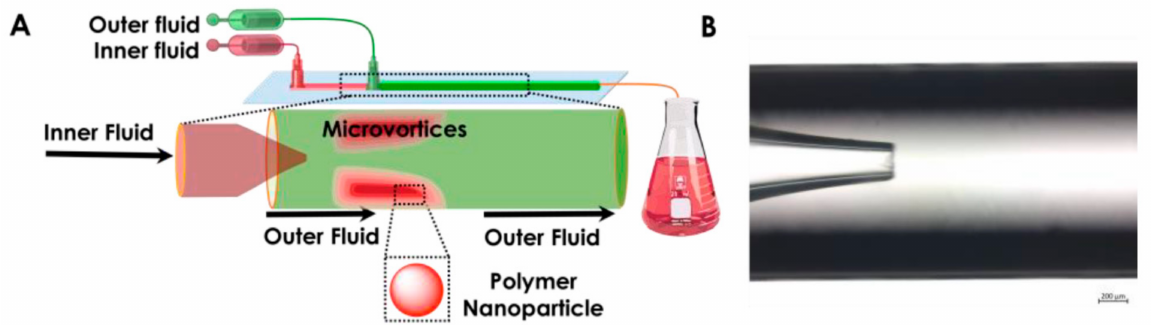
Figure 11. ( A ) Schematic representation of 3D co-flow microfluidics and ( B ) Digital view of the inner and outer capillary. Reprinted from an open-access source